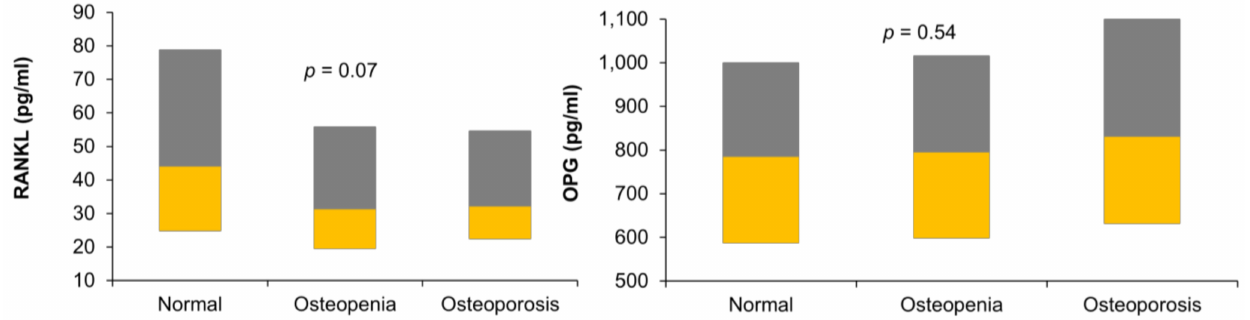
Figure 1. Boxplot showing the levels of receptor activator of nuclear factor-kappa B ligand (RANKL) and osteoportegerin (OPG) in the three study